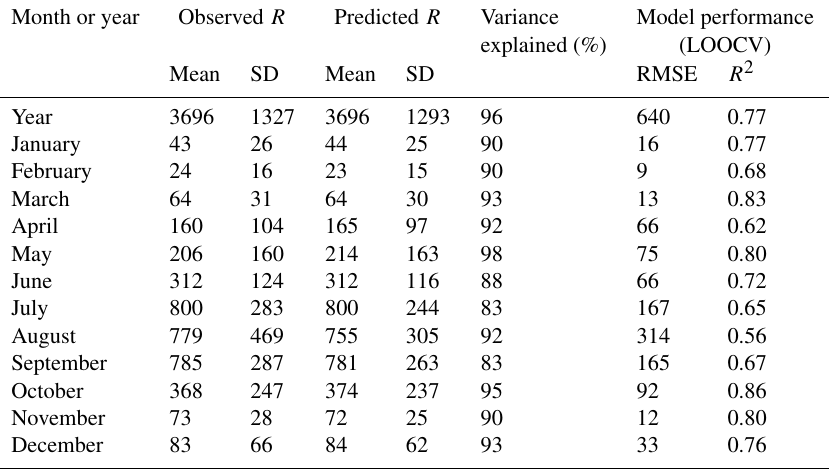
Table 2. Observed and predicted mean and standard deviation (SD) for monthly (inMJmmha − 1 h − 1 m − 1 ) and annual R factors (in